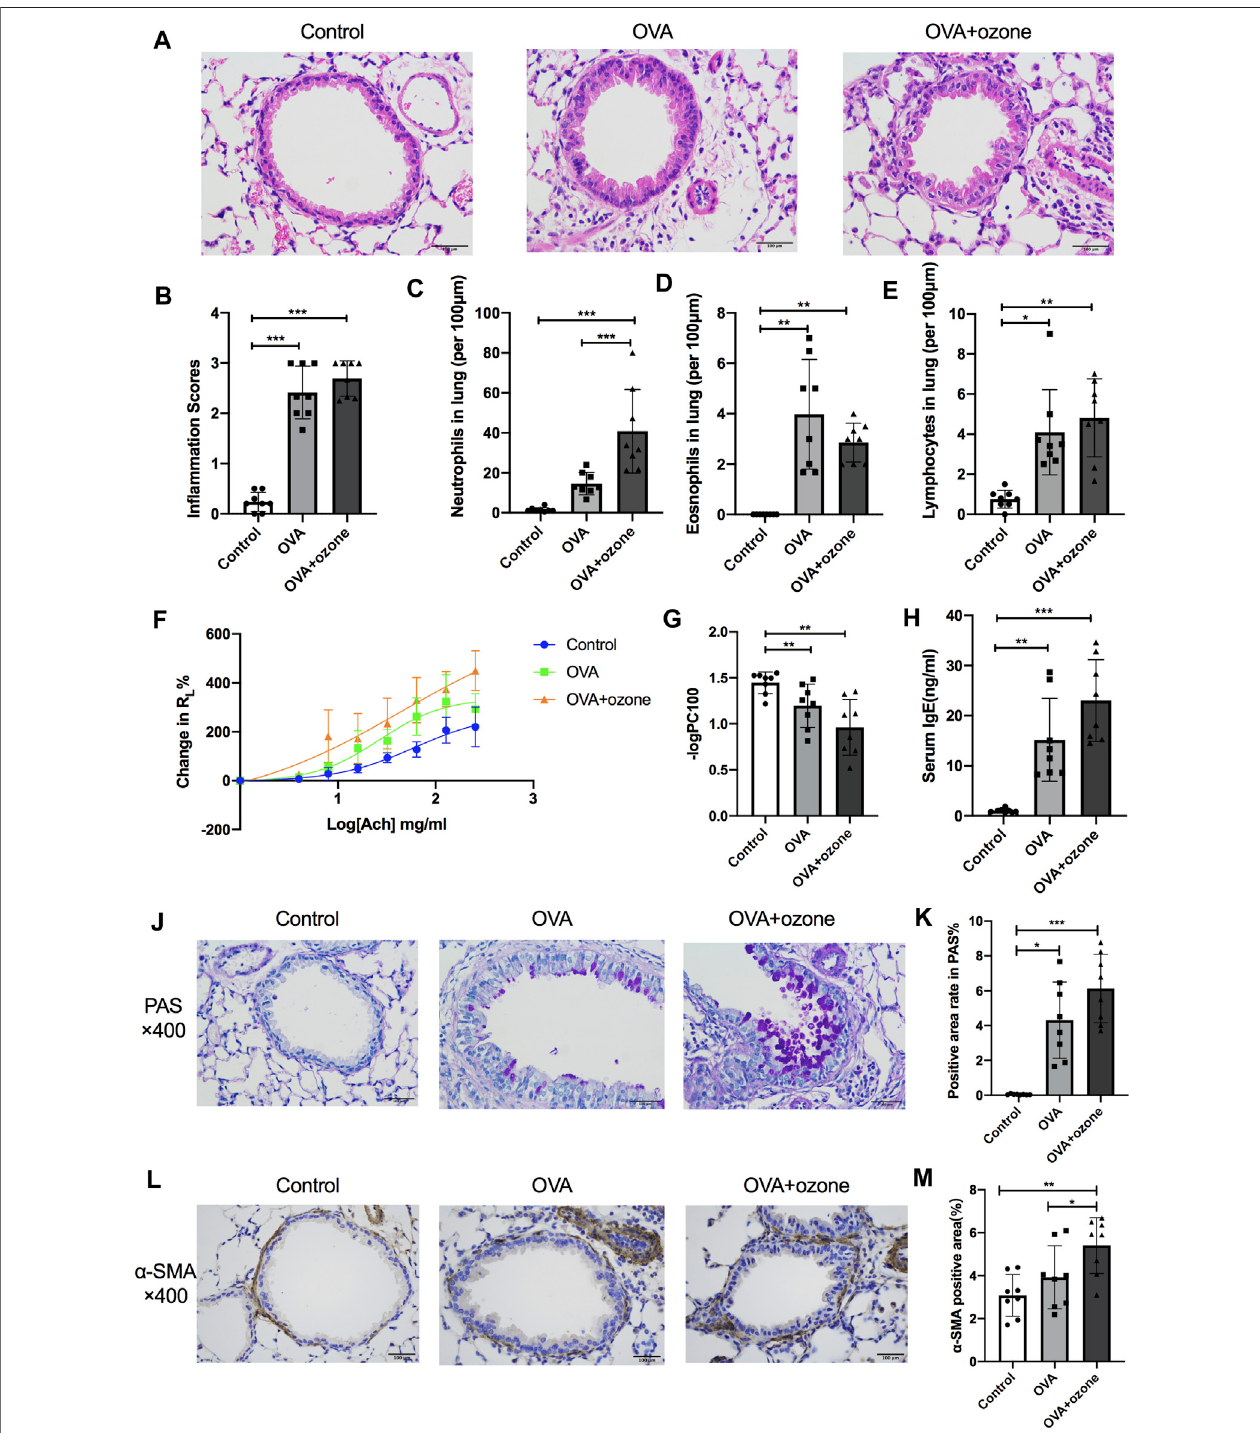
FIGURE 2 | Mucus secretion, in fl ammation, responsiveness, and remodeling of the airways and IgE level of serum in T2-high and T2-low asthma models. Airway in fl ammation was evaluated through H&E staining. The IgE level in serum was analyzed by ELISAs. R L (to acetylcholine chloride) was measured by a commercial setup from Electro-Medical Measurement Systems. (A) Representative photomicrographs of the lung with in fl ammatory-cell in fi ltration and hyperemia in hematoxylin and eosin – stained sections. (B) Airway in fl ammation scores. (C) Density of neutrophil in fi ltration. (D) Density of eosinophil in fi ltration. (E) Density of lymphocyte in fi ltration. (F) Mean percent increase in R L in response to increasing concentrations of ACh. (G) – logPC100 (the ACh concentration required to increase R L by 100% frombaseline). (H) IgElevelinserum. (J) Representativephotomicrographsofthelungwithairwaymucusproductionandgoblet-cellhyperplasia. (K) PAS-positivearea. (L) Representative photomicrographs of immunohistochemistry of α -SMA in lung-tissue slices. (M) Percent SMA-positive area around airways. ACh, acetylcholine chloride; R L , lung resistance; α -SMA, α -smooth muscle actin. * p < 0.05; ** p < 0.01; *** p < 0.001. Scale bar (cid:1) 100 μ m.